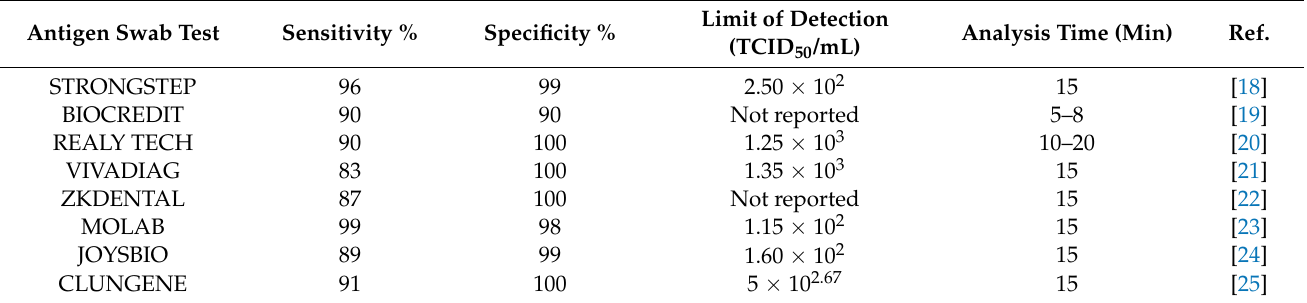
Table 1. Commercially available antigen